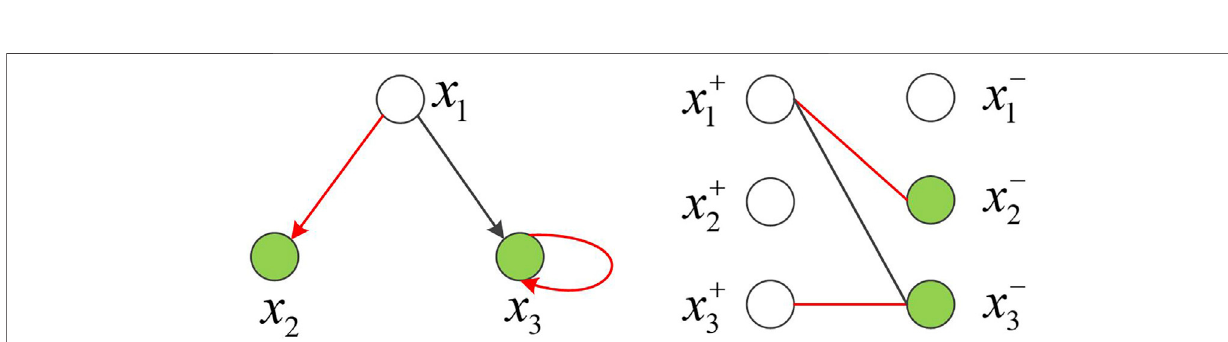
FIGURE 7 | Network controllability diagram (Liu and Jiang, 2010). (A) Four-node network (B) State evolution path.